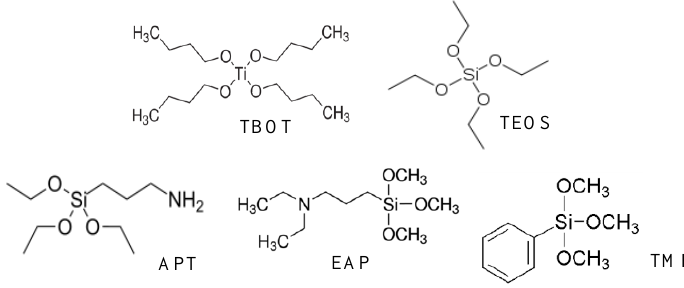
Figure 1. Molecular structure of two matrix precursors and three functional monomers.